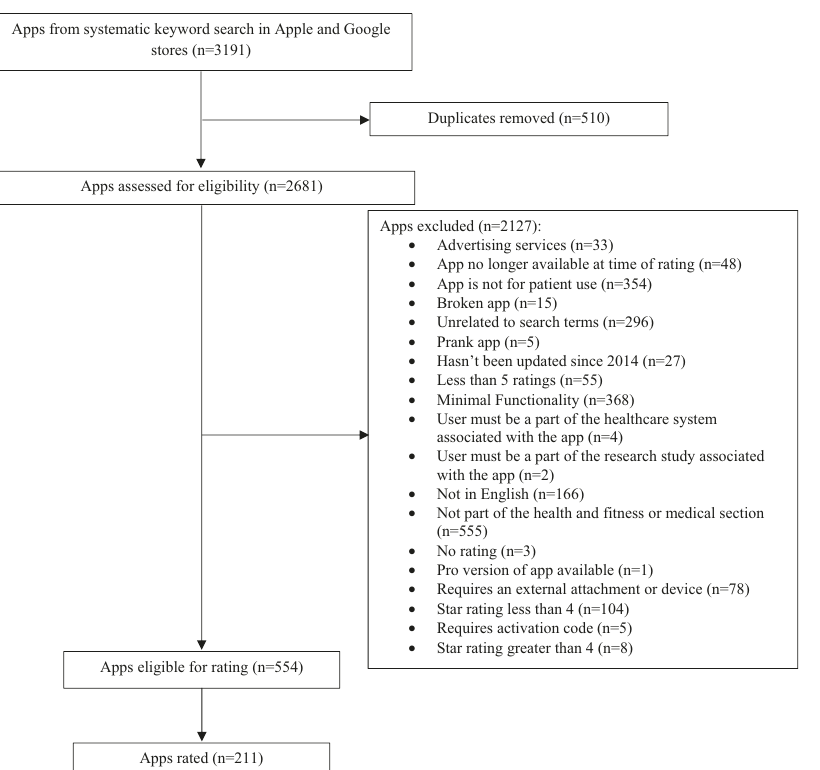
Fig. 1 App selection (all categories combined). We selected the fi rst four apps in each disease category. Not all apps were rated due to resource constraints. Please refer to Supplementary Figs. 1 – 3 for individual category selection